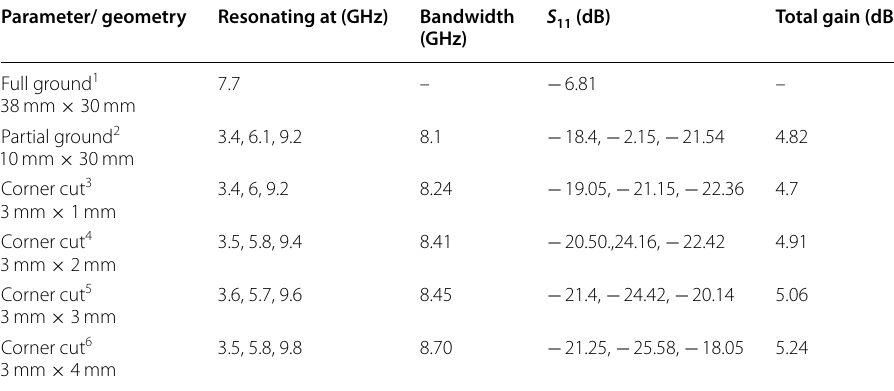
Table 2 Parametric results with variation in the ground plane Parameter/ geometry Resonating at (GHz) Bandwidth S 11 (dB) Total gain (dB) (GHz) 7.7 – 6.81 – Full ground 1 − 38mm × 30mm Partial ground 2 10mm ×